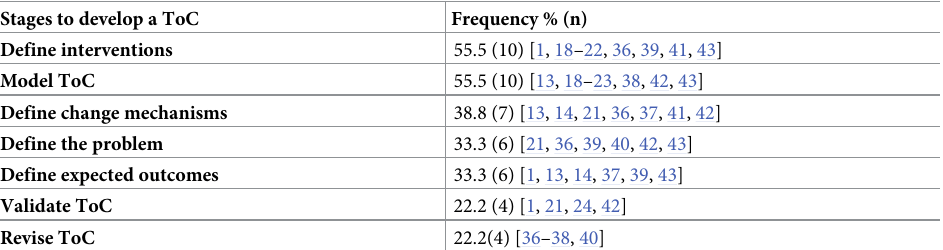
Table 3. Frequency of each stage of ToC